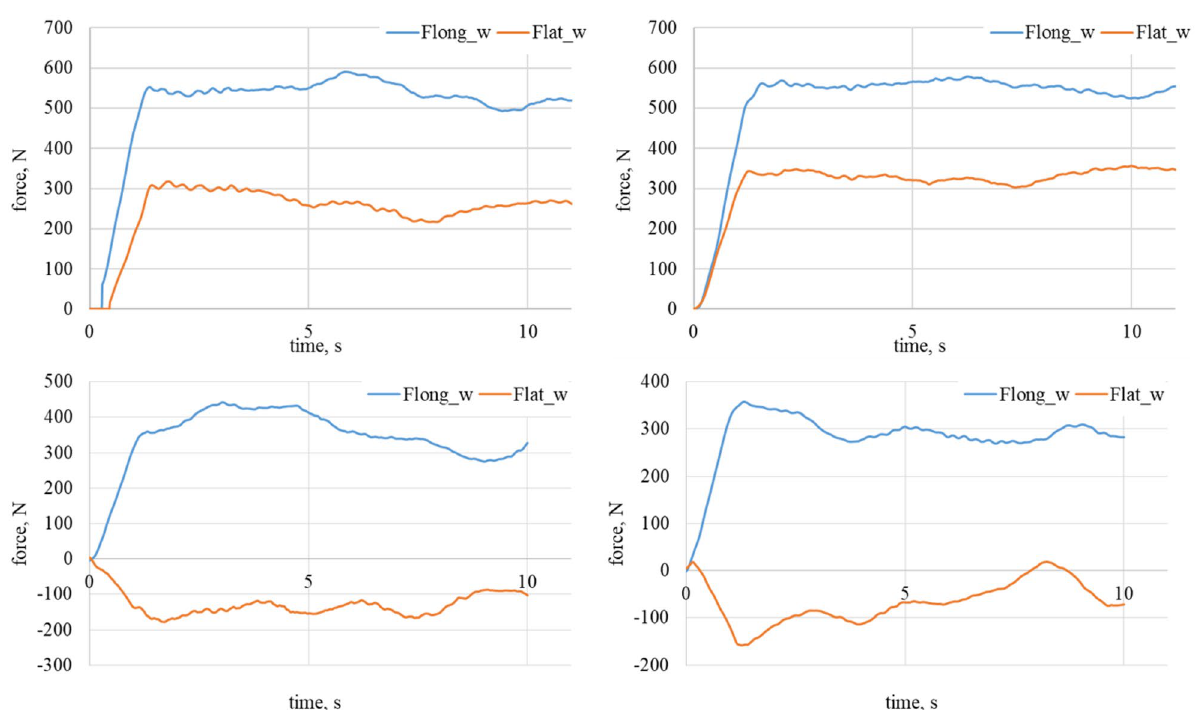
Figure 6. Longitudinal and lateral forces related to the wheel geometry α w = 30°. On the top left waveform: dry granite; on the top right waveform: wet granite. On the bottom left waveform: loose snow; on the bottom right waveform: compacted